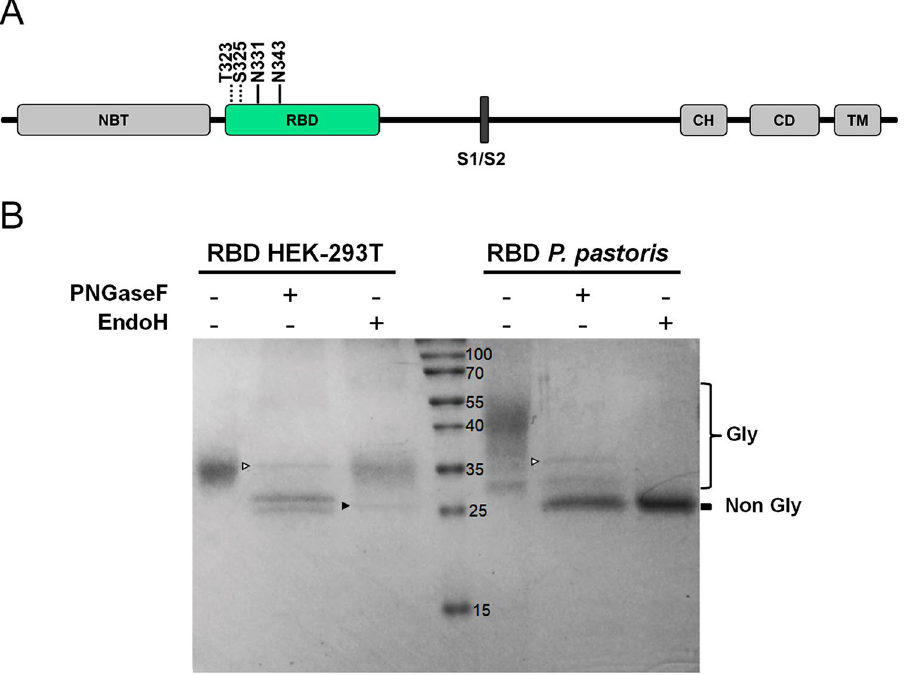
Figure 3. Analysis of the glycosylation status of RBD produced in HEK-293T and P. pastoris . ( A ) Schematic representation of SARS-CoV-2 S glycoprotein. N-terminal domain (NTD), receptor-binding domain (RBD), furin cleavage site (S1/S2), central helix (CH), connector domain (CD), and transmembrane domain (TM) are displayed. Residues involved in RBD glycosylation are shown ( O - and N -glycosylations are indicated by dotted and solid lines, respectively). ( B ) Endoglycanase treatment of RBD. Purified RBD (3 µg) from mammalian or yeast culture supernatants was denatured 10 min at 100 °C and digested with PNGase F (500 mU) or EndoH (5 mU) during 2 h at 37 °C. Proteins were separated in a 14% SDS-PAGE gel. The positions of non-glycosylated and glycosylated RBD isoforms are indicated. The bands corresponding to PNGaseF (36 KDa) and EndoH (29 KDa) are indicated by empty or full arrowheads,